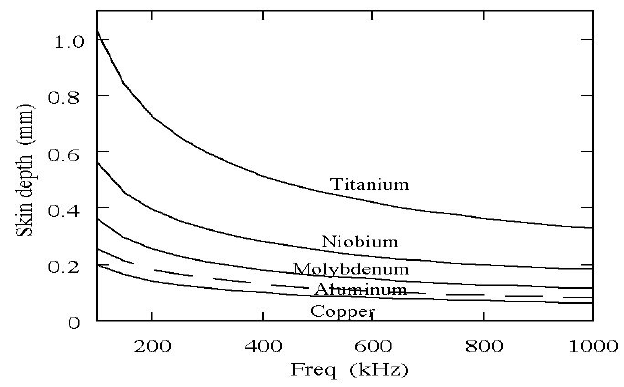
Figure 24: Variation of skin-depth with